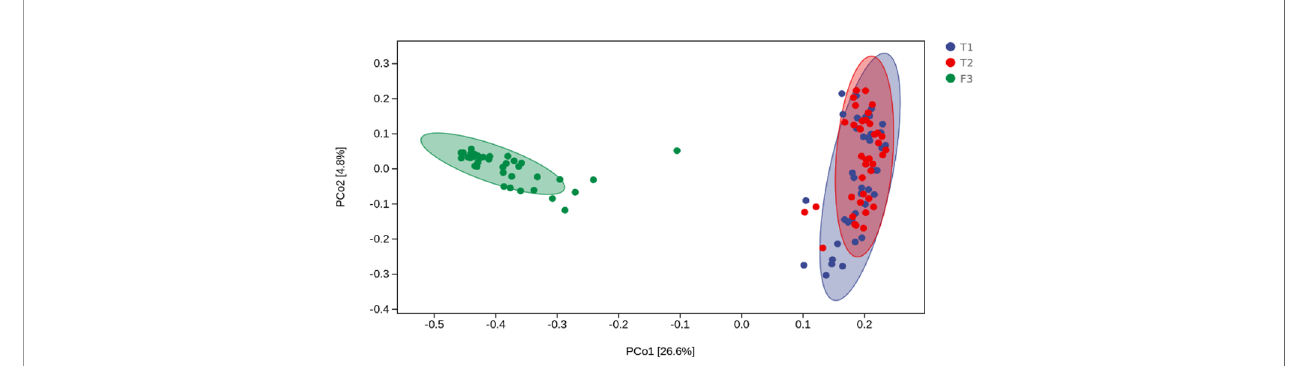
FIGURE 7 | The principal coordinate analysis diagram of the composition of tongue coating and intestinal microbiota (the percentage in the brackets of the coordinate axis represents the proportion of sample difference data (distance matrix) that can be explained by the corresponding coordinate axis.).